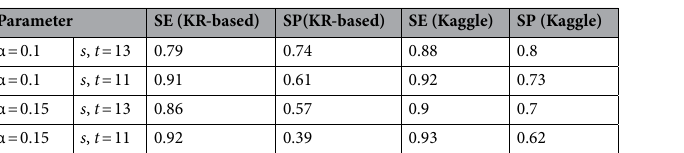
Table 1. The summary of SE and SP parameters for CIBICA method for KR-based and Kaggle datasets.